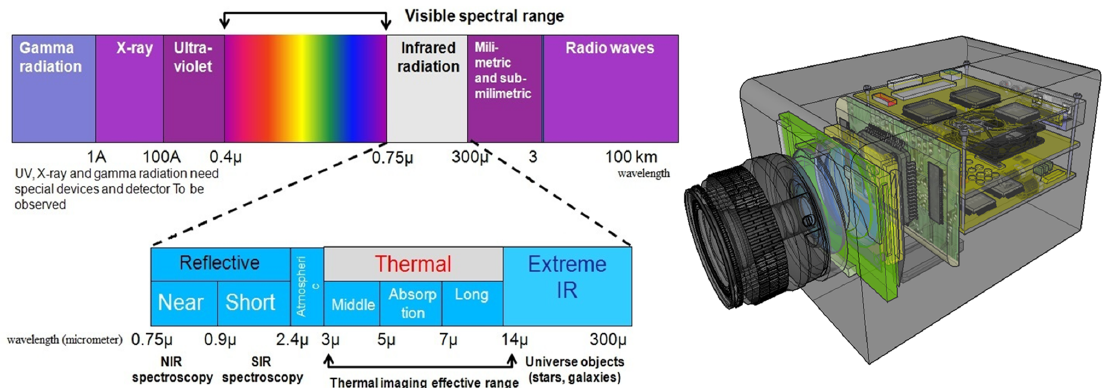
Figure 4. Electromagnetic (EM) spectrum showing infrared imaging band (reprinted with permission from one of the authors’ previous works